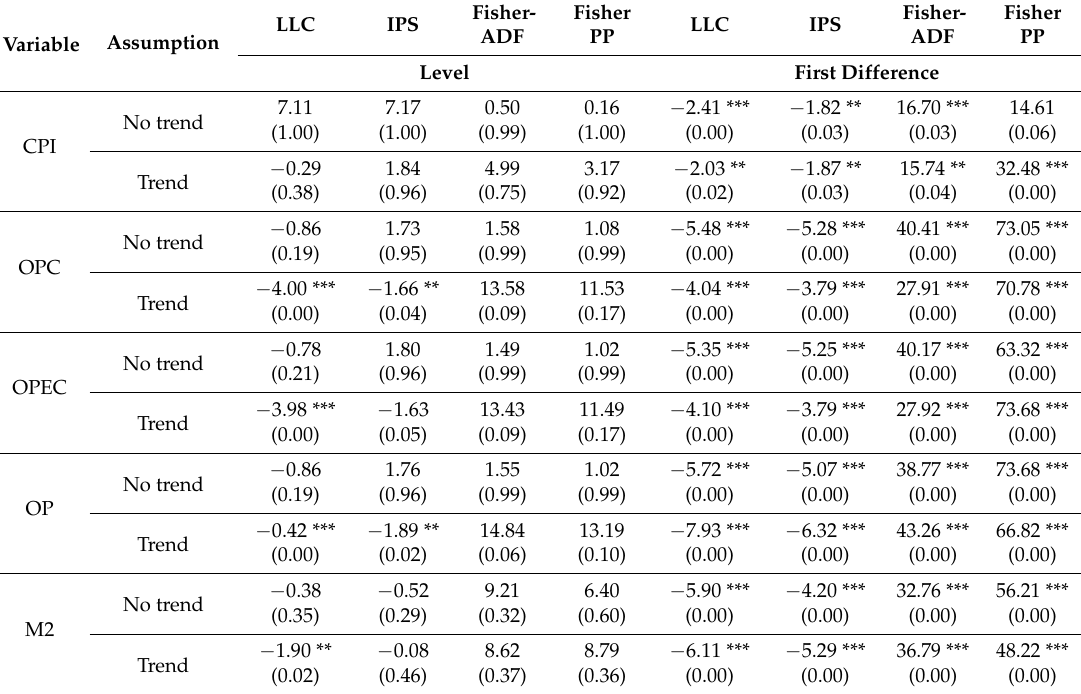
Table 2. Panel unit-root